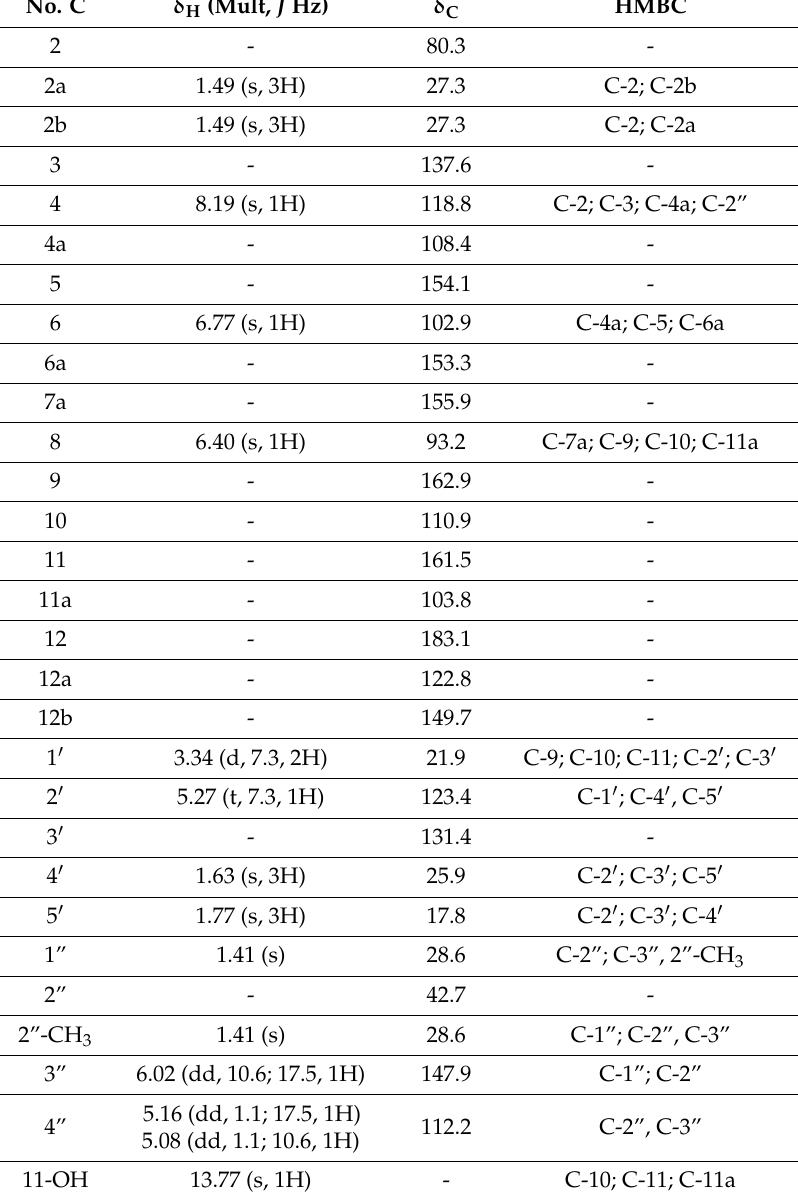
Table 1. NMR spectroscopic data of 5,9,11-trihydroxy-2,2-dimethyl-10-(3 (cid:48) -methyl-2 (cid:48)